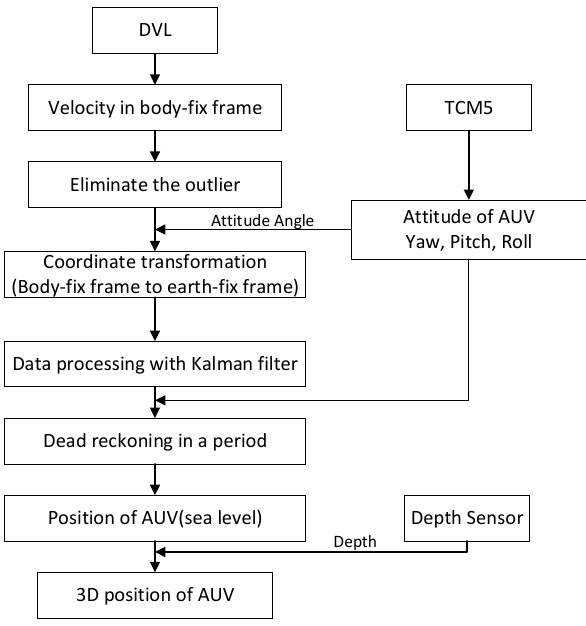
Figure 10. Dead-reckoning algorithm.